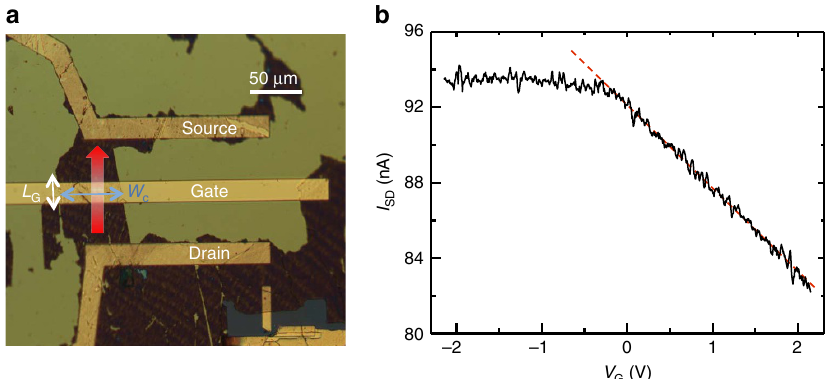
Figure 7 | Field effect transistor and transport data. ( a ) Optical microscope image of a top gate FETwith a channel made by printing the water-based ink (W-GSA sample). ( b ) Dependence of the source-drain FET current ( I DS ) from the gate bias V G in the range from (cid:2) 2.2V to þ 2.2V, measured while a source-drain voltage V SD ¼ 1mV is applied. The dashed line represents the fit to the data in the linear region and gives a transconductance B 4.4nAV (cid:2) 1 .